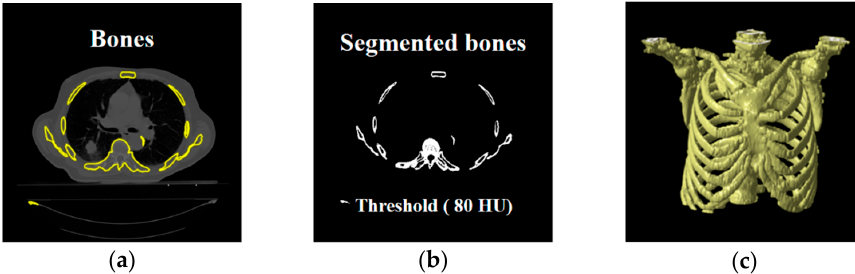
Figure 8. Segmentation of ribs and bones: ( a ) input 2D CT slice, ( b ) 2D segments of the ribs and bones, ( c ) isotropic structure of the ribs and bones.